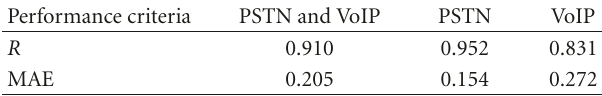
Table 6: Performance of the estimation on the test found in the literature according to the